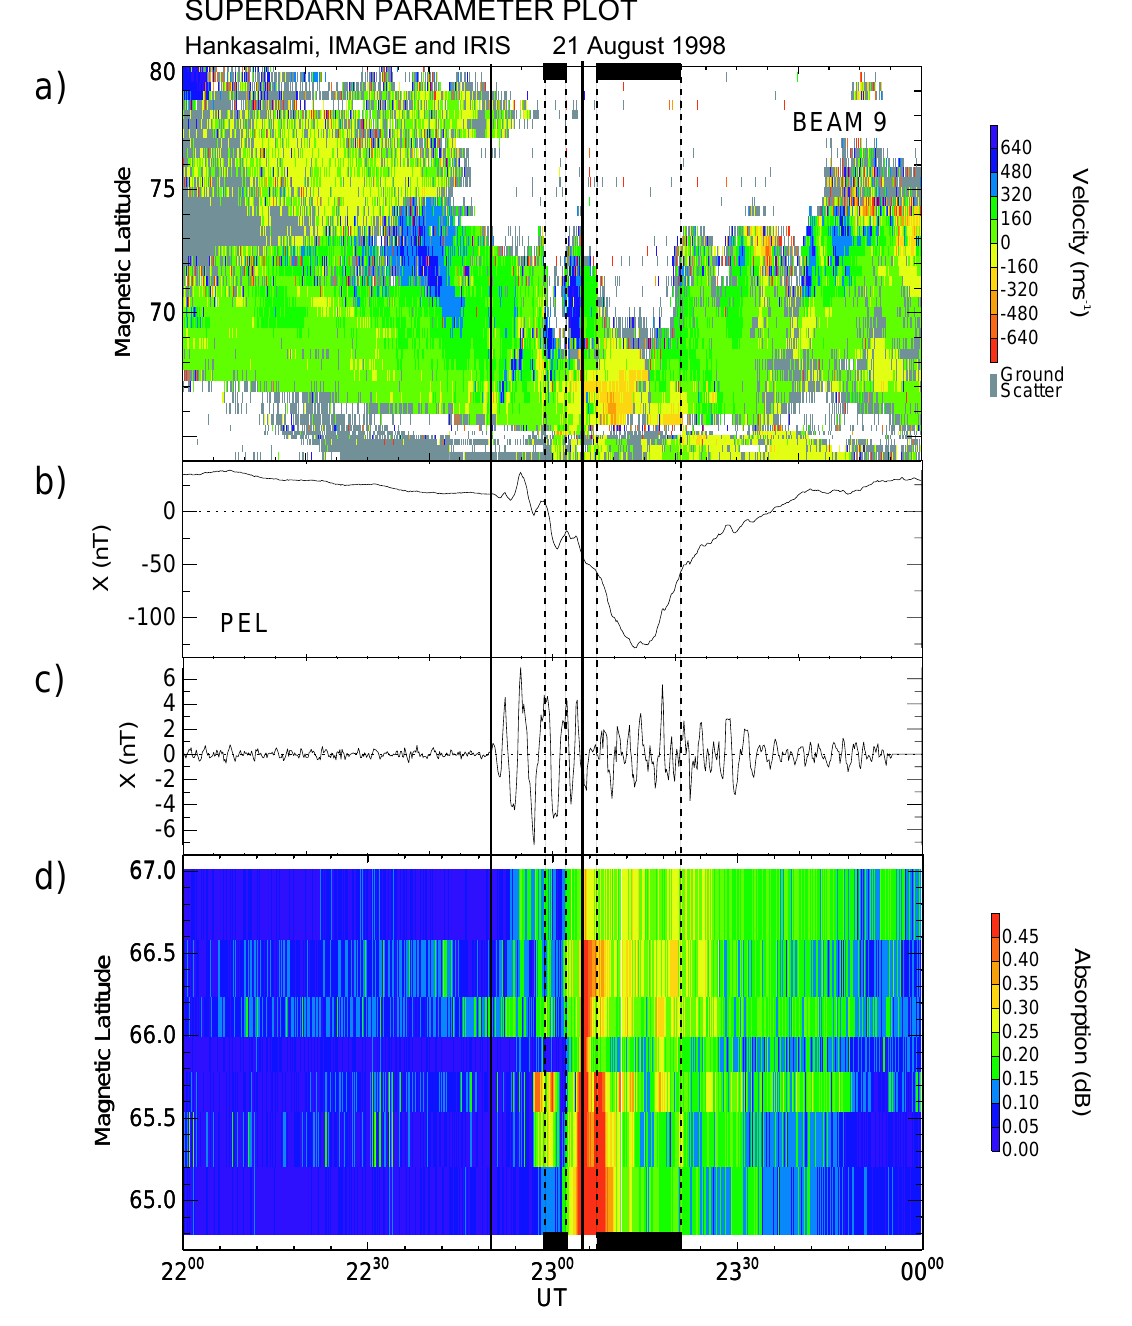
Fig. 2. Radar, magnetometer and riometer data for the isolated substorm under study. Pi2 onset times are marked with vertical solid lines and Fig. 2 the intervals of HF radar data loss with vertical dashed lines. (a) Hankasalmi beam 9 line-of-sight velocity data from 22:00–24:00UT, as a function of magnetic latitude, (b) unfiltered X (geographic north) component magnetogram from the PEL station of the IMAGE array, over the same time interval, (c) as panel b, but with a 200–20s band-pass filter applied, in order to illustrate the Pi2 pulsation activity associated with the substorm expansion phase onset at 22:50UT, (d) a keogram of IRIS absorption measurements from 20 ◦ longitude.